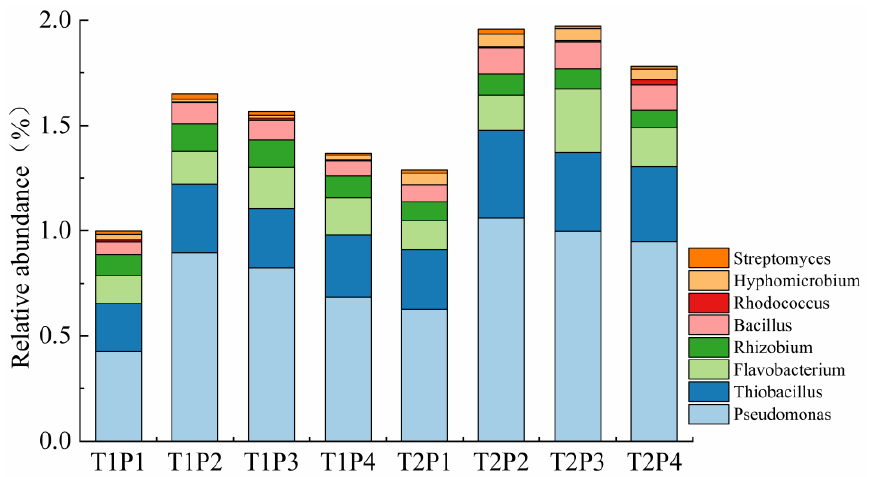
Figure 8. Relative abundance of soil phosphate -solubilizing bacteria at genus level under different treatments in 2020. Note; T1, no straw return; and T2, straw returning. P — No P application; P2 — P